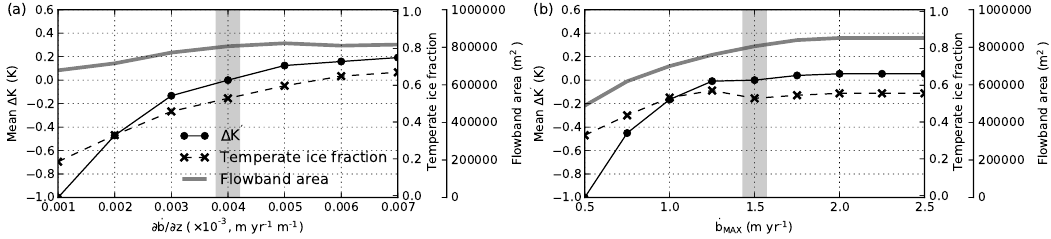
Fig. 5. The results of varying (a) mass balance gradient and (b) maximum mass balance, given in terms of mean equivalent temperature (solid line, dots) temperate fraction (dashed line, crosses), and flowband area (grey line). The glacier geometry is permitted to change in response to the changing net balance profile. The values used for the reference model are indicated by the vertical grey bars.